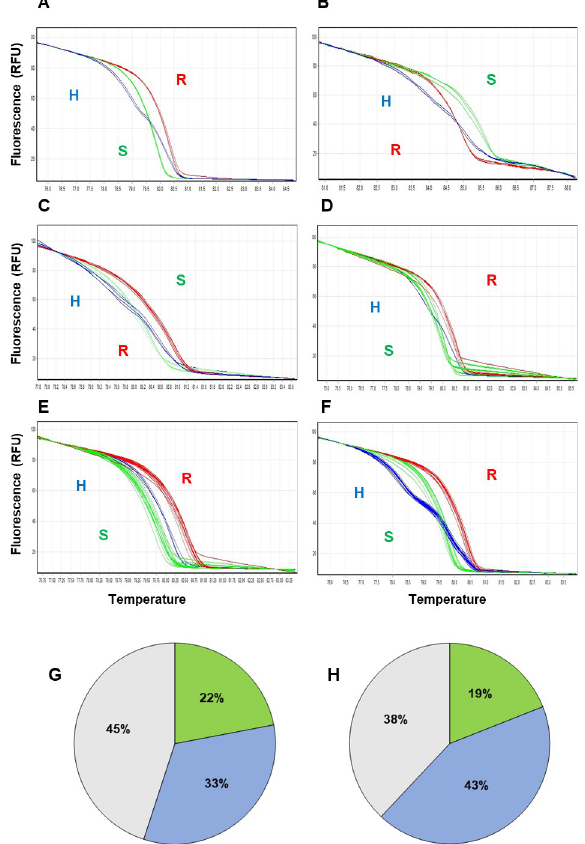
Fig 6. Validation of single markers. A) Parental survey with marker Chr7-LCV-7 on P7. B) Parental survey with marker Chr12-LCV-12 on P12. C) Marker Chr7-LCV-7 on P7 validation using resistant hybrids. D) Marker Chr12-LCV-12 on P12 validation using resistant hybrids. E) Marker Chr7-LCV-7 on P7 validation using additional F 2 segregating population Egale-F 2 . F) Marker Chr12-LCV-12 on P12 validation using additional F 2 segregating population Eagle-F 2 . G) Single marker Chr7-LCV-7 on P7 genotype–phenotype association in Eagle-F 2 . H) Single marker Chr12-LCV-12 on P12 genotype–phenotype association in the Eagle-F 2 population. (G & H) Green, blue and grey represents exact phenotype-genotype matched, when heterozygous counted as susceptible and unmatched, respectively.